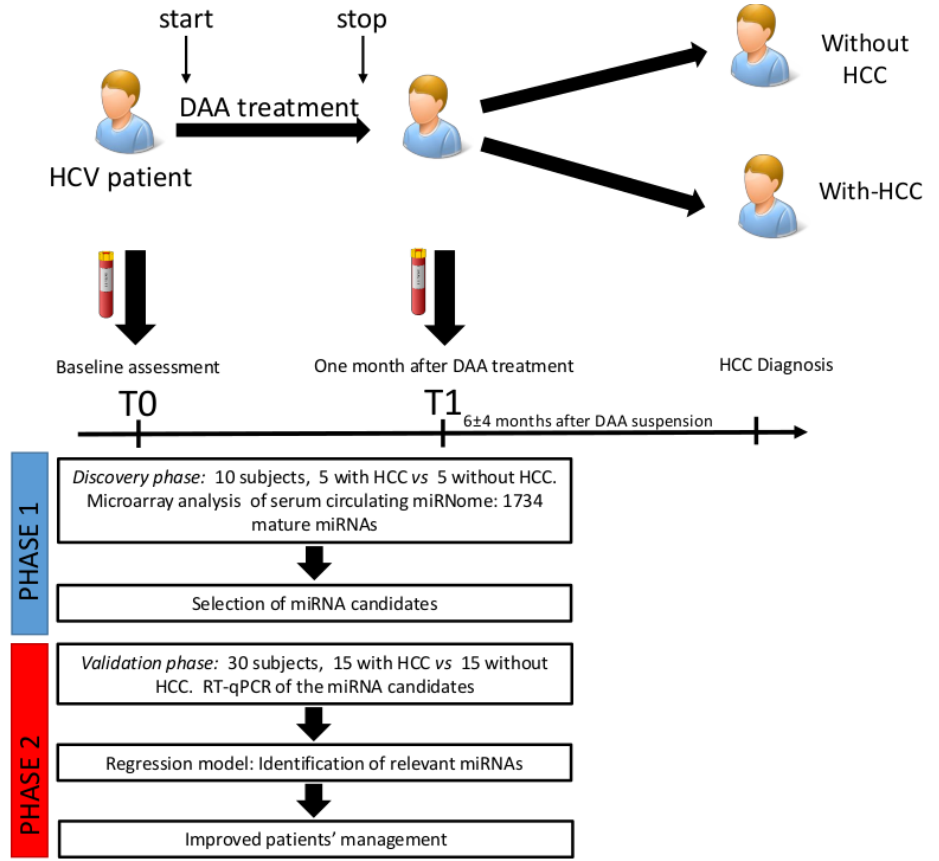
Figure 5. General scheme of the miRNA profiling study design. In the discovery phase 10 patients were enrolled and analyzed through a Genechip miRNA 3.0 array. Patients were divided into two groups, with-HCC (subjects developing HCC after DAA treatment) and without-HCC (subjects not developing HCC after DAA treatment). Samples were analyzed at T0 and T1. Subsequently, miRNA candidates were assessed by qRT-PCR in 30 patients (validation cohort). MiRNA biomarkers were selected by estimating the time-averaged difference of a given miRNA between subjects with HCC vs. without HCC using a bootstrapped random-effect generalized least square regression model (RE-GLS).